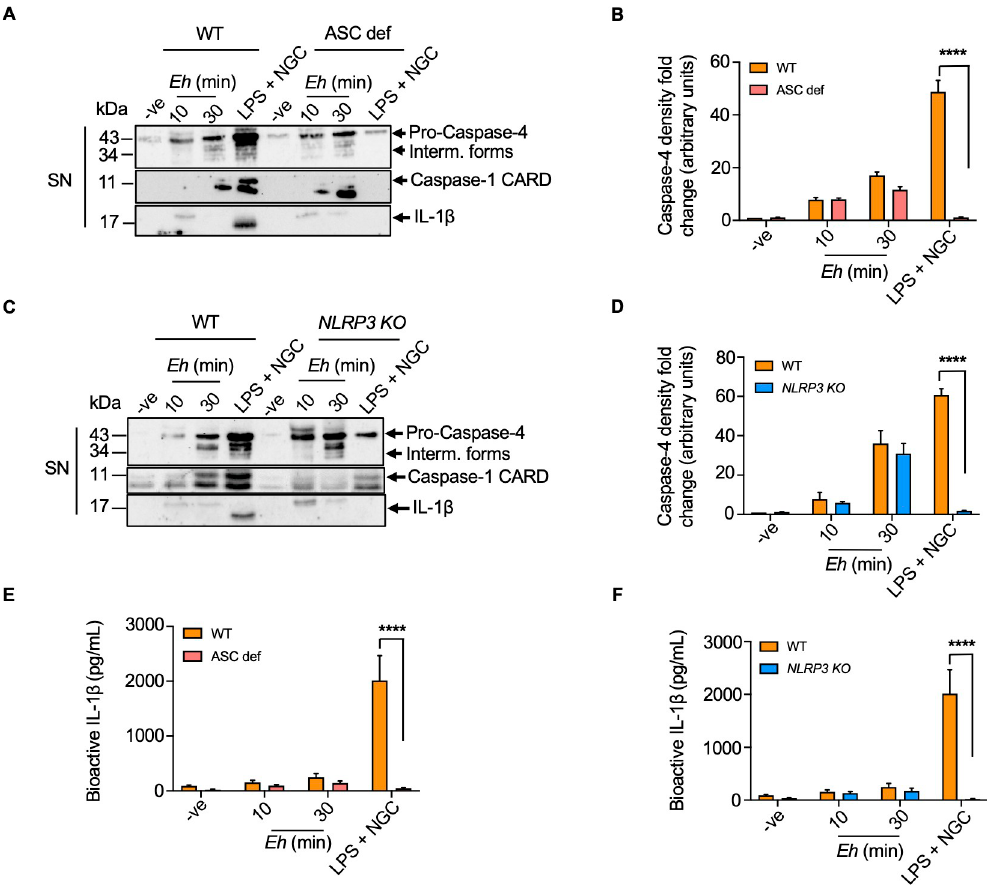
Fig 5. E . histolytica -induced caspase-4 activation does not require the recruitment of the canonical inflammasome components. (A, B) WT and ASC deficient (ASC def) macrophages were treated with Eh (20:1) for 10 min and 30 min, respectively. Macrophages stimulated with LPS (50 ng/mL) and NGC (10 μ M) acted as a positive control. Eh -induced caspase-4 activation was independent of ASC confirmed by aborted caspase-1 activation and IL-1 β secretion. Quantifications of active caspase-4 were performed by densitometric analysis and statistical significance was calculated between WT and ASC def macrophages at each time point. (C, D) WT and CRISPR/Cas9 NLRP3 KO macrophages were stimulated with Eh (20:1) at 10 min and 30 min, respectively. Macrophages stimulated with LPS (50 ng/mL) and NGC (10 μ M) were used as a positive control. Quantifications of activated caspase-4 were confirmed with densitometric analysis and statistical significance was calculated between WT and NLRP3 KO macrophages at each time point. Cell supernatant (SN) was TCA precipitated and equal amount of cell supernatants was loaded onto SDS-PAGE and immunoblot analysis was performed for caspase-4, caspase-1 and IL-1 β . (E, F) Bioactive IL-1 β secretion in the cell supernatant was quantified by the SEAP assay in HEK-Blue reporter cells and statistical significance was calculated between WT and ASC def, WT and NLRP3 KO macrophages at each time point. Data and immunoblots are representative of at least three independent experiments (n = 3) and statistical significance was calculated with Student’s t-test between KO and WT ( ���� p < 0.0001). Bars represent mean ±